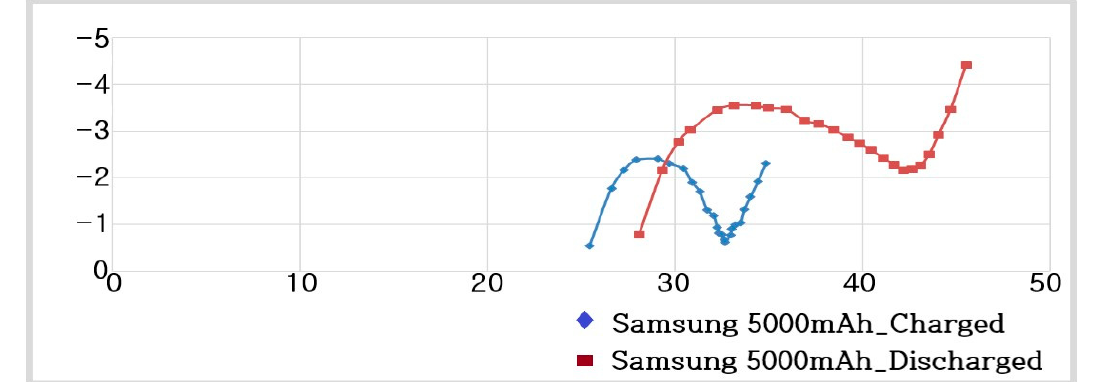
Figure 20. Impedance spectra of 2600 mAh 18650-type Li-ion batteries (built-in protection device).